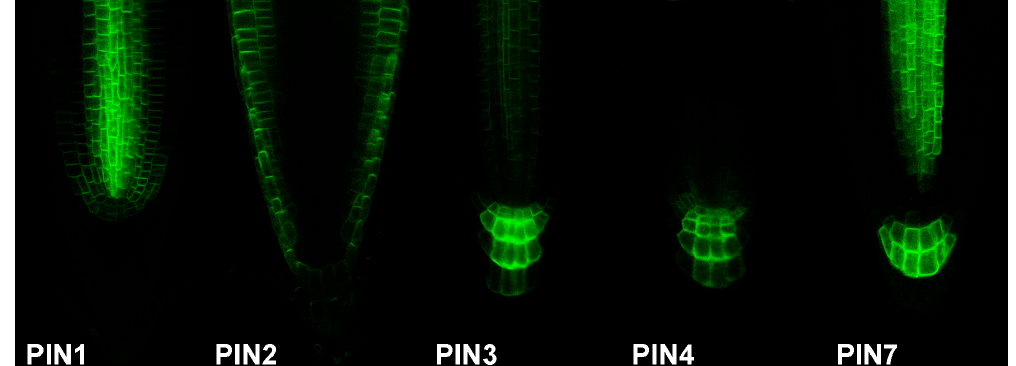
Figure 2. Visualisation of auxin flow. Functional translational fusion of auxin transport proteins enables to predict auxin distribution in Arabidopsis root tip. Auxin efflux carriers from the PIN family were fused with GFP. PIN, PIN-FORMED.